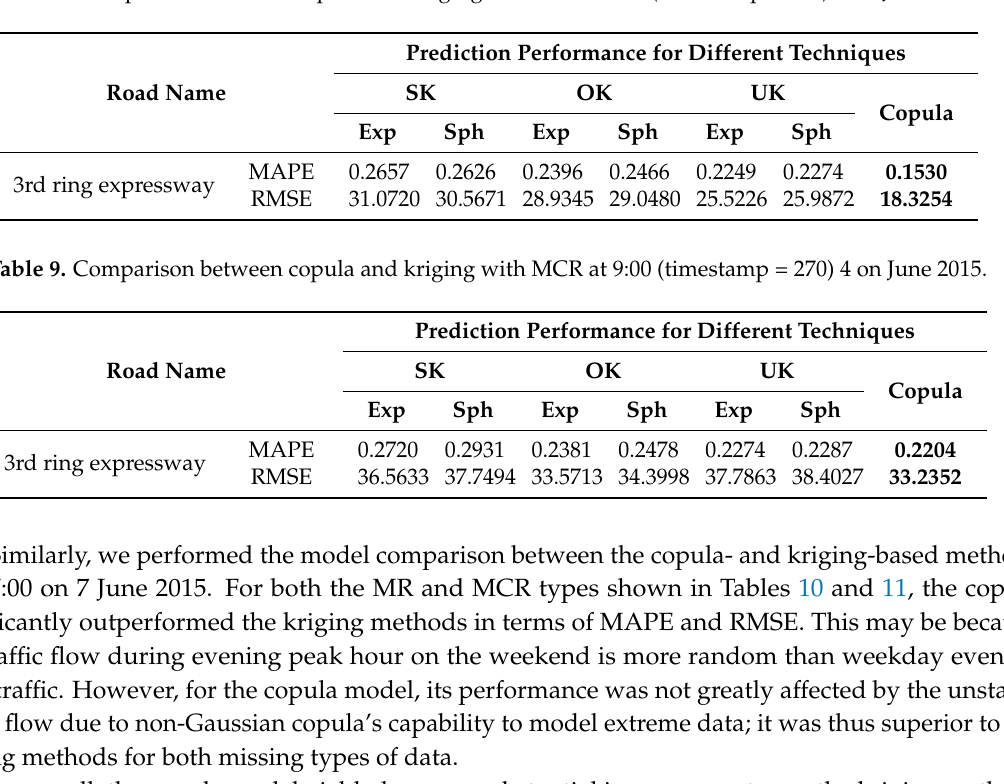
Table 8. Comparison between copula and kriging with MR at 9:00 (timestamp = 270) on 4 June 2015.